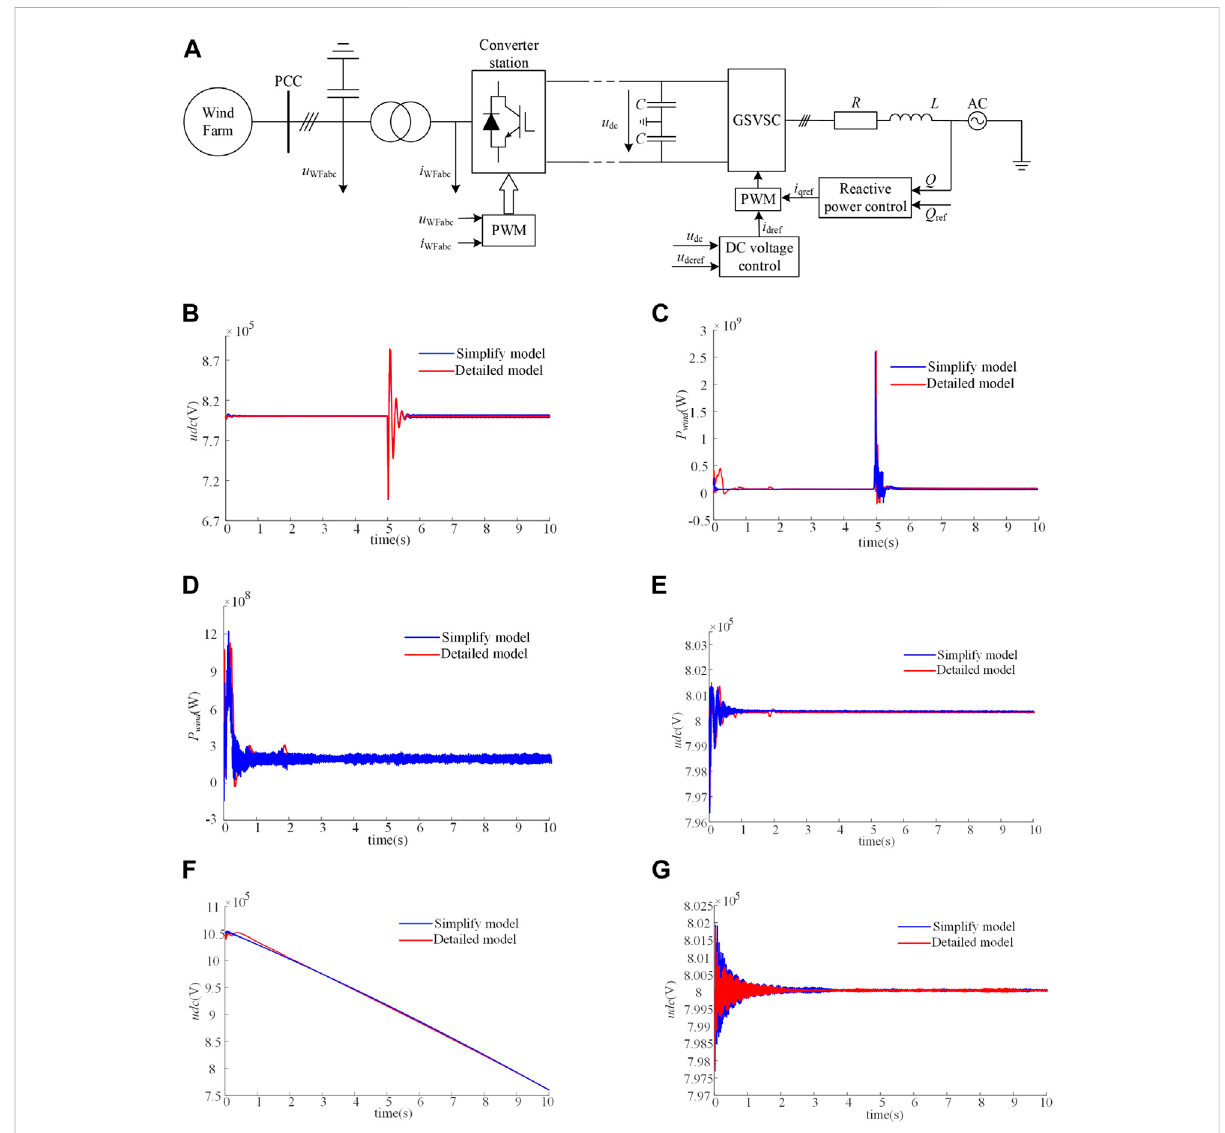
FIGURE 9 Simpli fi ed equivalent wind farm grid integration Analysis based on MMC-HVDC. (A) is a simpli fi ed equivalent wind farm grid-connected structure diagram based on MMC-HVDC, which provides a model basis for subsequent simulation analysis. (B,C) DC voltage and output power waveformsofthewindfarmwhenathree-phasegroundfaultoccursintheACcircuitofthewindfarm. (D,E) showtheoutputpowerandDCvoltage waveforms of the wind farm when a three-phase ground fault occurs at the grid-connected end. (F,G) DC voltage waveform on the wind farm side and the grid-connected side when a fault occurs on the DC transmission line. The aforementioned waveforms compare the dynamic characteristics of the simpli fi ed equivalent model and the detailed model under various operating conditions and verify the validity of the simpli fi ed equivalent